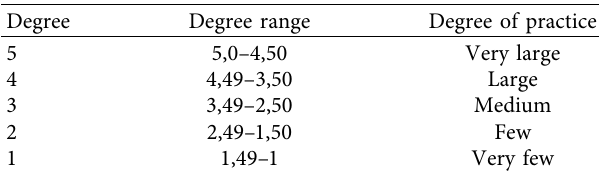
Figure 1: Research framework of the study. Table 1: The statistical standard for interpreting the estimates of individuals in the